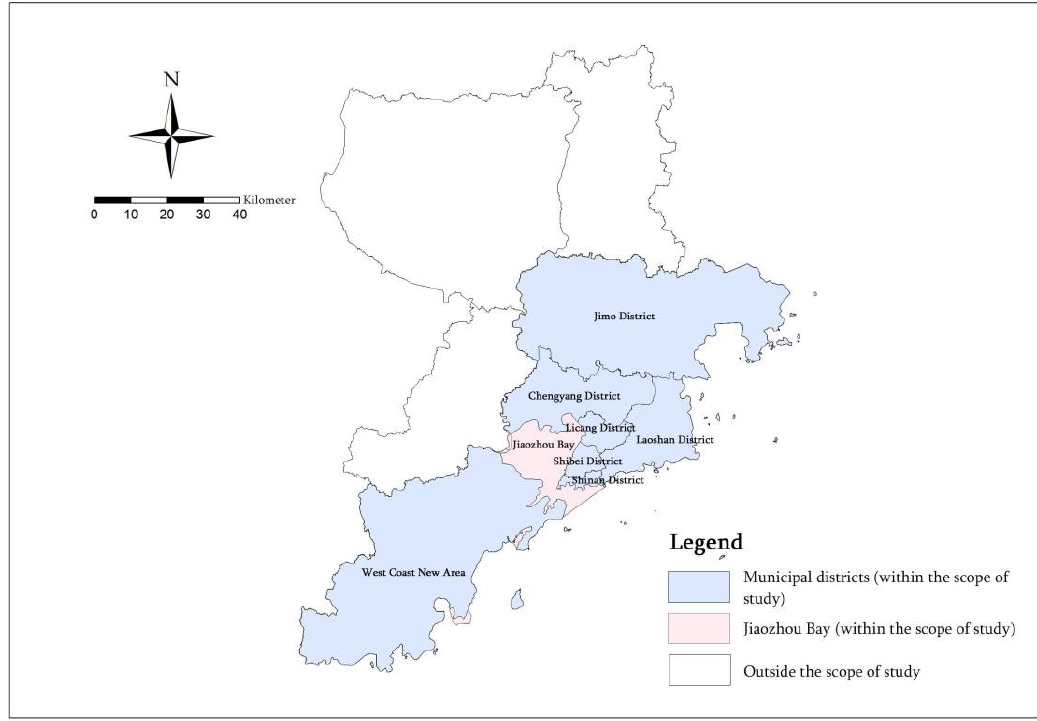
Figure 2. Map of the Study Area.